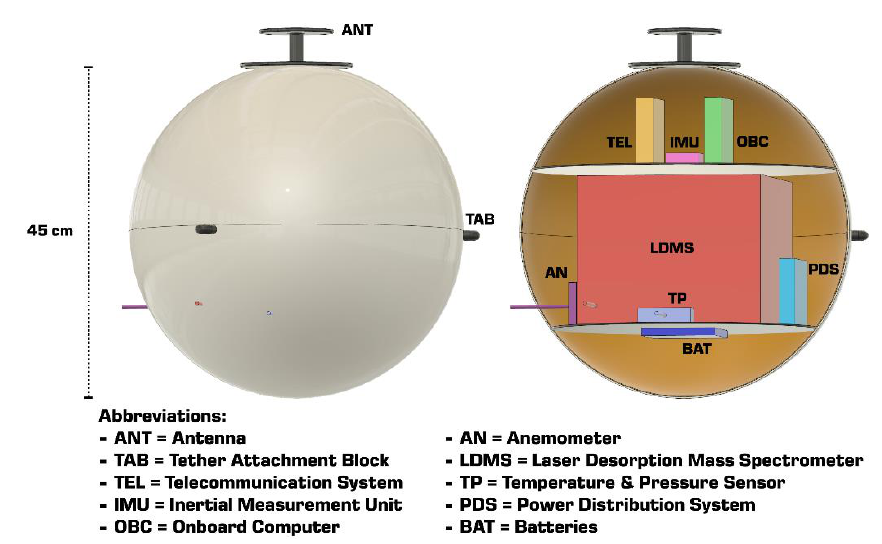
Figure 5. Concept design for the LDMS descent probe. The probe is a 45 cm spherical titanium shell of 2 mm thickness. The forward and aft shelves are made of beryllium of thickness equal to that of the hull wall and are coated with sodium silicate. A thin layer of Kapton lines the interior of the probe. The LDMS is fastened to the forward shelf, with other non-science subsystems distributed among both shelves. There are three protrusions in the hull wall: one for the anemometer; a second for the temperature and pressure sensor; and a third for the antenna. A single penetration is required for the LDMS sample collection mechanism. The total mass of the probe likely will not exceed 44.4 kg, with the current best estimate being 34.2 kg. 5. Summary and Conclusions The VLF Habitability Mission is a streamlined mission concept designed to answer key questions about the habitability of the clouds of Venus as well as search for signs of life. Determining cloud particle characteristics — their acidity and chemical composition, including water content and the presence of dissolved metals — is of central focus. The mission also aims to resolve longstanding chemical anomalies of the clouds of Venus, in- cluding the presence of ammonia, molecular oxygen, and the anomalous shapes of the Mode 3 cloud particles, all of which are motivated by the search for signs of habitability and life. The data on cloud particles’ physical and chemical properties returned by the Habit- ability Mission will also inform the future development of sample capture, storage, and transfer technologies. Together with balloon deployment and operation, the mission will demonstrate critical technologies needed for a successful atmosphere sample return mis- sion. Author Contributions: Conceptualization, S.S., J.J.P., C.E.C., S.J.S., R.A., W.P.B. and D.H.G.; meth- odology, S.S., J.J.P., C.E.C., S.J.S., R.A., W.P.B. and I.I.; formal analysis, S.S., J.J.P., C.E.C., S.J.S., R.A., W.P.B. and I.I.; investigation, S.S., J.J.P., C.E.C., S.J.S., R.A., W.P.B., D.H.G., M.U.W., P.K., S.P.W., I.I., M.P. and L.K.; writing — original draft preparation, S.S. and J.J.P.; writing — review and editing, S.S., J.J.P., C.E.C., S.J.S., R.A., W.P.B., D.H.G., M.U.W., P.K., S.P.W., I.I., M.P. and L.K. All authors have read and agreed to the published version of the manuscript. Funding: This research was partially funded by Breakthrough Initiatives, the Change Happens Foundation, and the Massachusetts Institute of Technology. Acknowledgments: We thank the extended Venus Life Finder Mission team for useful discussions. List of the individuals involved as the VLF extended Venus Life Finder Mission team can be found here: https://venuscloudlife.com/, accessed on 14th of May 2022